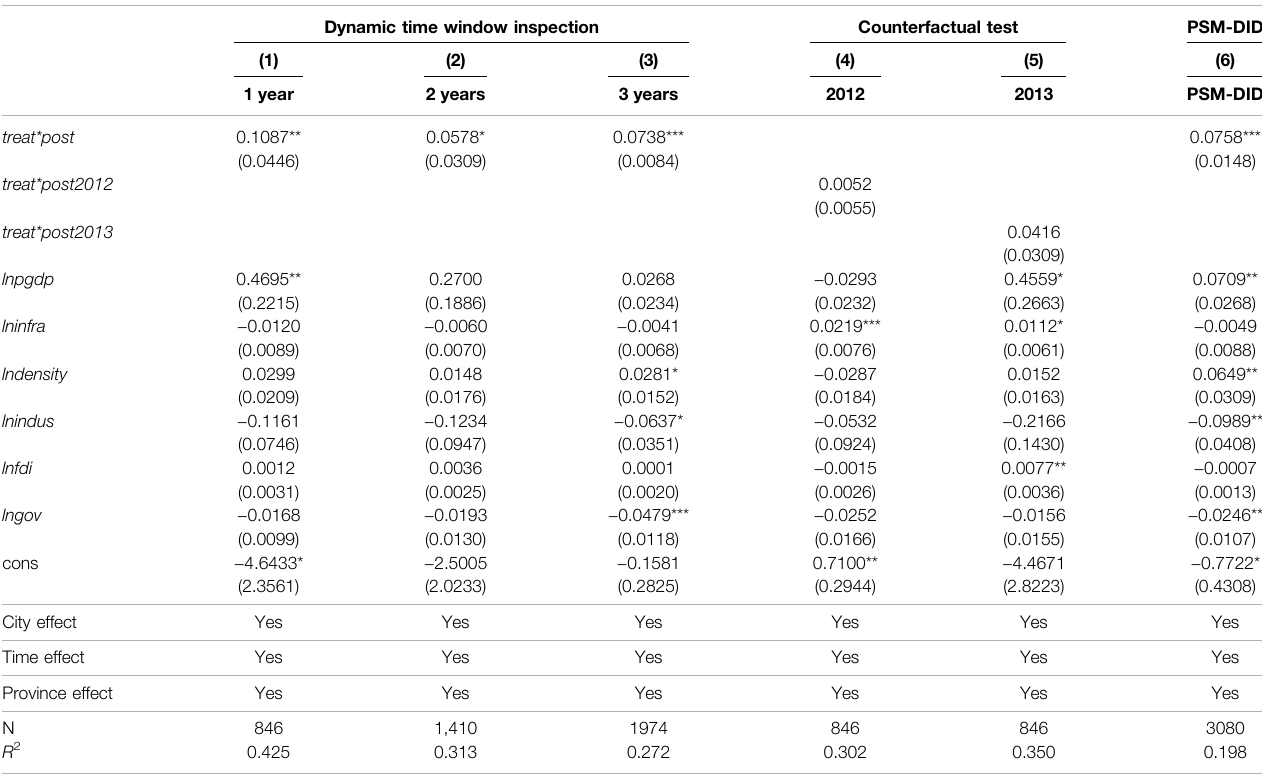
TABLE 4 | The results of robustness